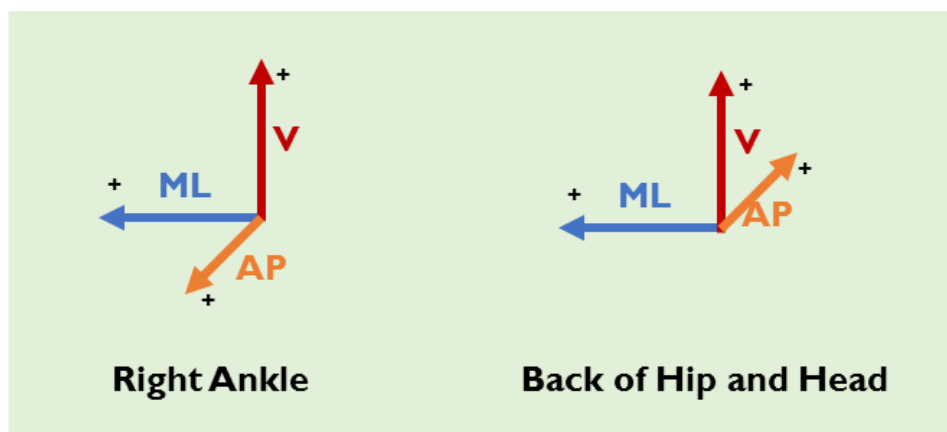
Figure 5. Accelerometers ’ directions for all three locations.